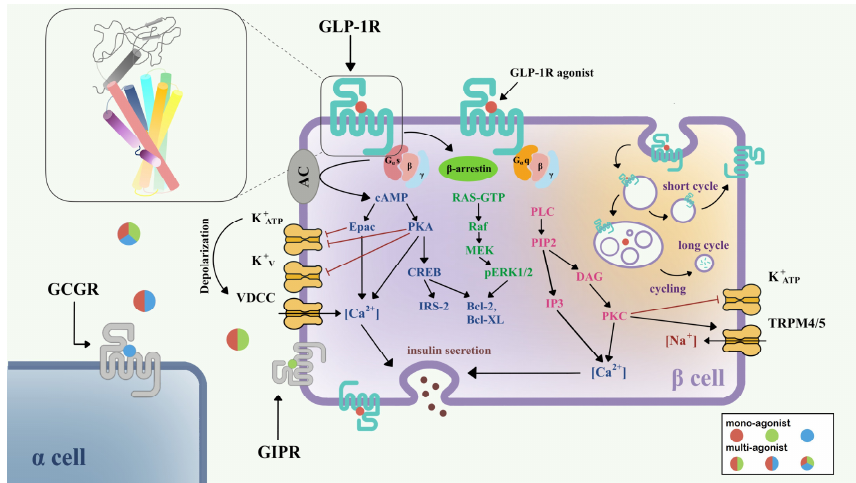
Figure 1. Signaling pathways of GLP-1R in pancreatic β -cell [15,30]. Three downstream signaling pathways initiated from Gαs (blue), Gαq (pink), and β-arrestin (green) are shown in the left half of the β-cell. The GLP-1R internalization process and insulin secretion after GLP-1R activation are also shown. Colored circles show mono-agonists targeting GLP-1R (red), GIPR (green), and GCGR (blue), and multi-agonists targeting GLP-1R/GIPR (red/green), GLP-1R/GCGR (red/blue), and GLP- 1R/GIPR/GCGR (red/green/blue). The top left inset shows the structure of GLP-1R with a seven- transmembrane helix bundle and a large ECD. Abbreviations: VDCC, voltage-dependent calcium channel; TRPM, the transient receptor potential melastatin; GCGR, glucagon receptor; GIPR, gastric inhibitory polypeptide receptor.